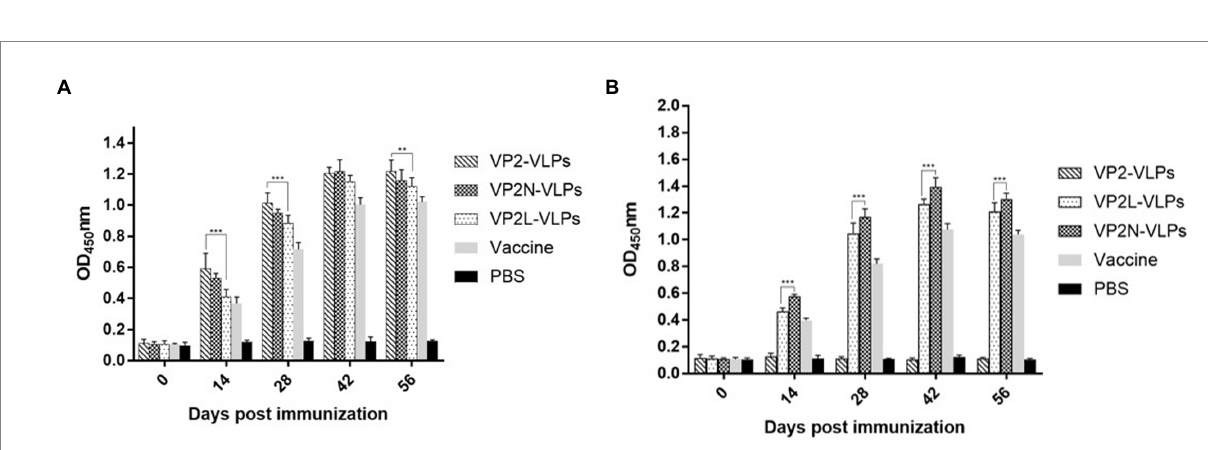
FIGURE 5 Detection of specific CPV/CDV antibodies in mice immunized with CPV VP2/VP2N/VP2L by indirect ELISA. Each group of 6-week-old Balb/c mice ( n = 10) were immunized subcutaneously with 50 μ g of VP2, VP2L, VP2N recombinant protein, 100 μ l CPV/CDV live-attenuated vaccine and 100 μ l PBS at 0, 14, 28 dpi. Blood was collected at 0, 14, 28, 42, 56 dpi and serum was obtained to determine the antibody titers of CPV/CDV. (A) Antibody titers of CPV in mice were determined by ELISA. (B) Antibody titers of CDV in mice serum were determined by ELISA. Data were analyzed using GraphPad 5.00. Asterisks indicate significant differences among the groups, as calculated by one-way ANOVA (** p < 0.01, *** p < 0.001).